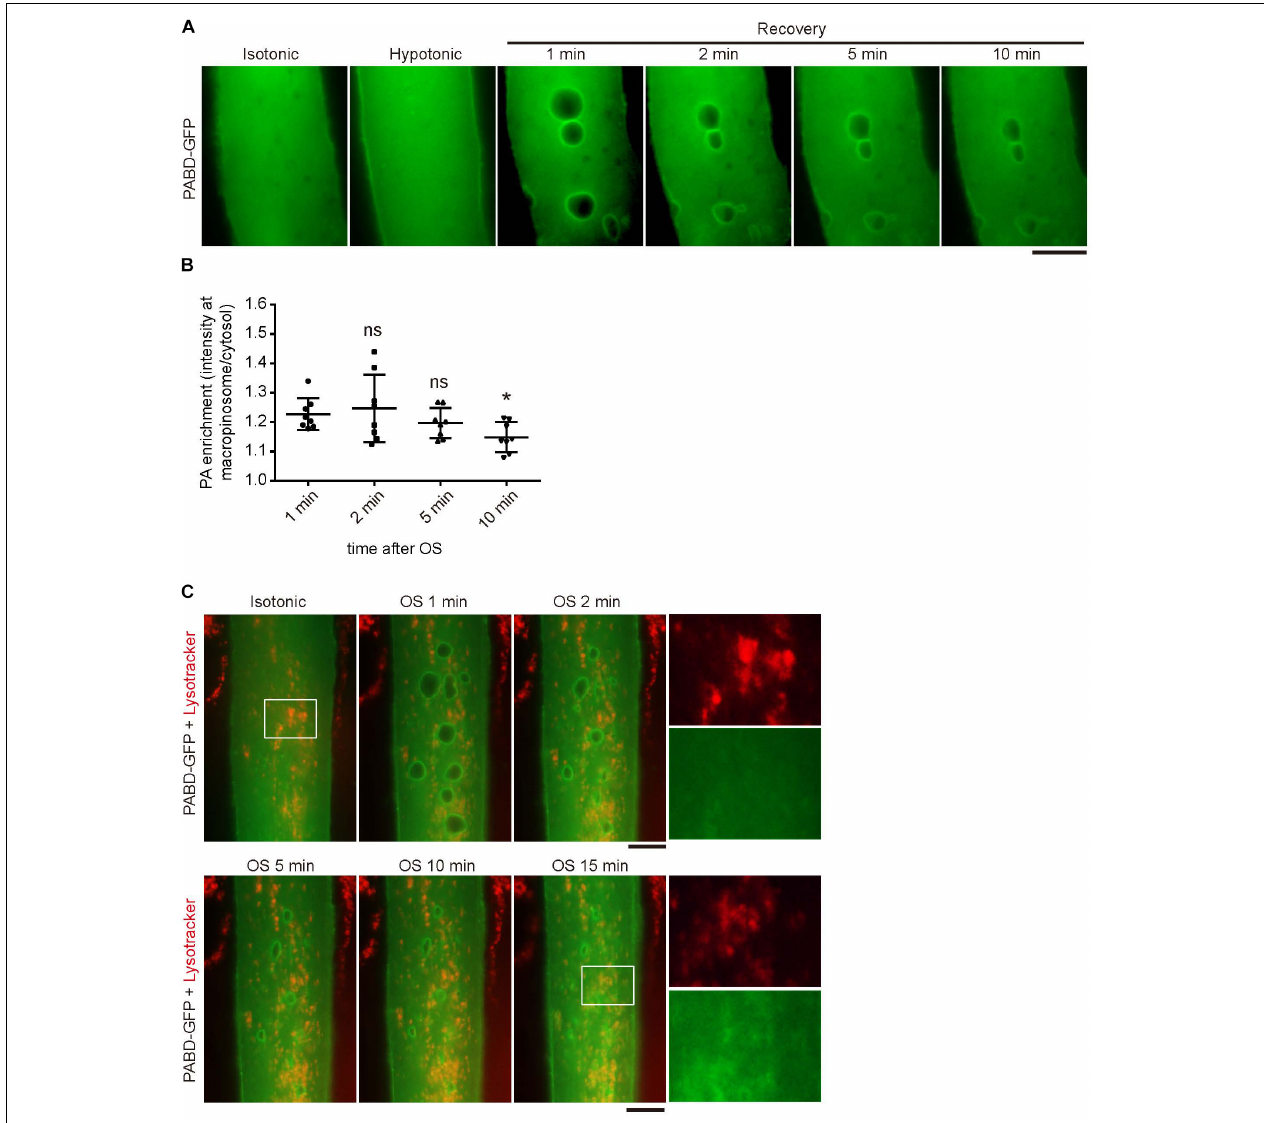
FIGURE 2 | Phosphatidic acid (PA) is enriched at macropinosome but not lysosome upon OS treatment. (A,B) The enrichment and duration of PA at macropinosome. PABD-GFP expressing myotube was subjected to OS treatment and time-lapse microscopy images were shown. The intensity of PABD-GFP at the macropinosome or cytosol were quantified upon OS treatment and shown in (B) . Eight macropinosomes in (A) were quantified and analyzed. (C) PABD-GFP was not accumulated on lysosome upon OS treatment. After incubation with lysotracker for 15 min, PABD-GFP expressing myotube was imaged with time-lapse microscopy upon OS treatment. Boxed areas were magnified and shown. Scale bars: 10 mm. ∗ p < 0.05.